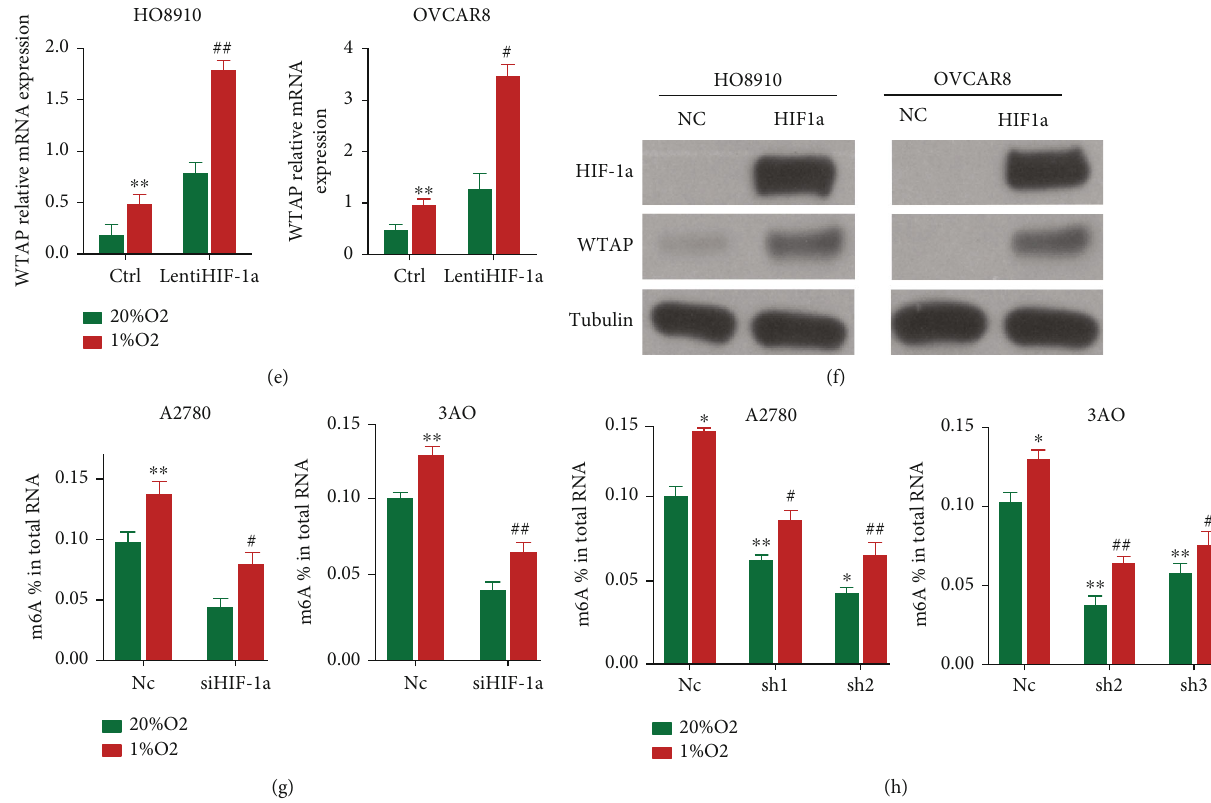
Figure 1: Hypoxia-induced and HIF-1 α -dependent WTAP expression mediates an alteration in total RNA m6A levels. (a) WTAP were remarkably upregulated under hypoxic microenvironment of 1% O2 condition compared to 20% O condition in two ovarian cancer cell 2 lines (3AO and A2780) through analysis of whole genome expression pro fi le. (b) Six human ovarian cancer cell lines (A2780, 3AO, SKOV3, OVCAR3, HO8910, and OVCAR8) were exposed to 20% or 1% O for 24h, and WTAP mRNA expression was determined by 2 RT-qPCR relative to 18S rRNA and normalized to the mean value for A2780 cells at 20% O ( ∗∗ P < 0 : 01 and ∗∗∗ P < 0 : 001 ). (c) OC cells 2 were exposed to 20% and 1% O for 48h, Western blot experiments were performed to analyze HIF-1 α and WTAP protein expression. 2 Tubulin was detected as a loading control. ( ∗∗ P < 0 : 01 , and ∗∗∗ P < 0 : 001 ). (d) CHIP-PCR experiment was applied and the results demonstrated that HIF-1 α which acted as a transcription factor could bind to the region corresponding to primer 9 and 10 in the promoter region of WTAP. (e) HO8910 and OVCAR8 Ctrl and LentiHIF-1 α subclones were exposed to 20% or 1% O for 24 h. WTAP 2 mRNA expression levels were determined as a percentage of all adenosine residues in RNA ( ∗∗ P < 0 : 01 vs. 20% O ; # P < 0 : 05 and 2 ## P < 0 : 01 vs. 1% O Ctrl). (f) Western blot experiments were performed to detect the expression levels of HIF-1 α and WTAP. (g) A2780 2 and 3AO Nc and siHIF-1 α subclones were exposed to 20% or 1% O for 24h. m6A levels were determined as a percentage of all 2 adenosine residues in RNA ( ∗∗ P < 0 : 01 vs. 20% O ; # P < 0 : 05 and ## P < 0 : 01 vs. 1% O NC). (h) A2780 and 3AO Nc and WTAP 2 2 for 24h. m6A content was determined as knockdown (sh1 sh2 in A2780 and sh2 sh3 in 3AO) subclones were exposed to 20% or 1% O 2 a percentage of all adenosine residues ( ∗ P < 0 : 05 and ∗∗ P < 0 : 01 vs. 20% O ; # P < 0 : 05 and ## P < 0 : 01 vs. 1% O 2 2